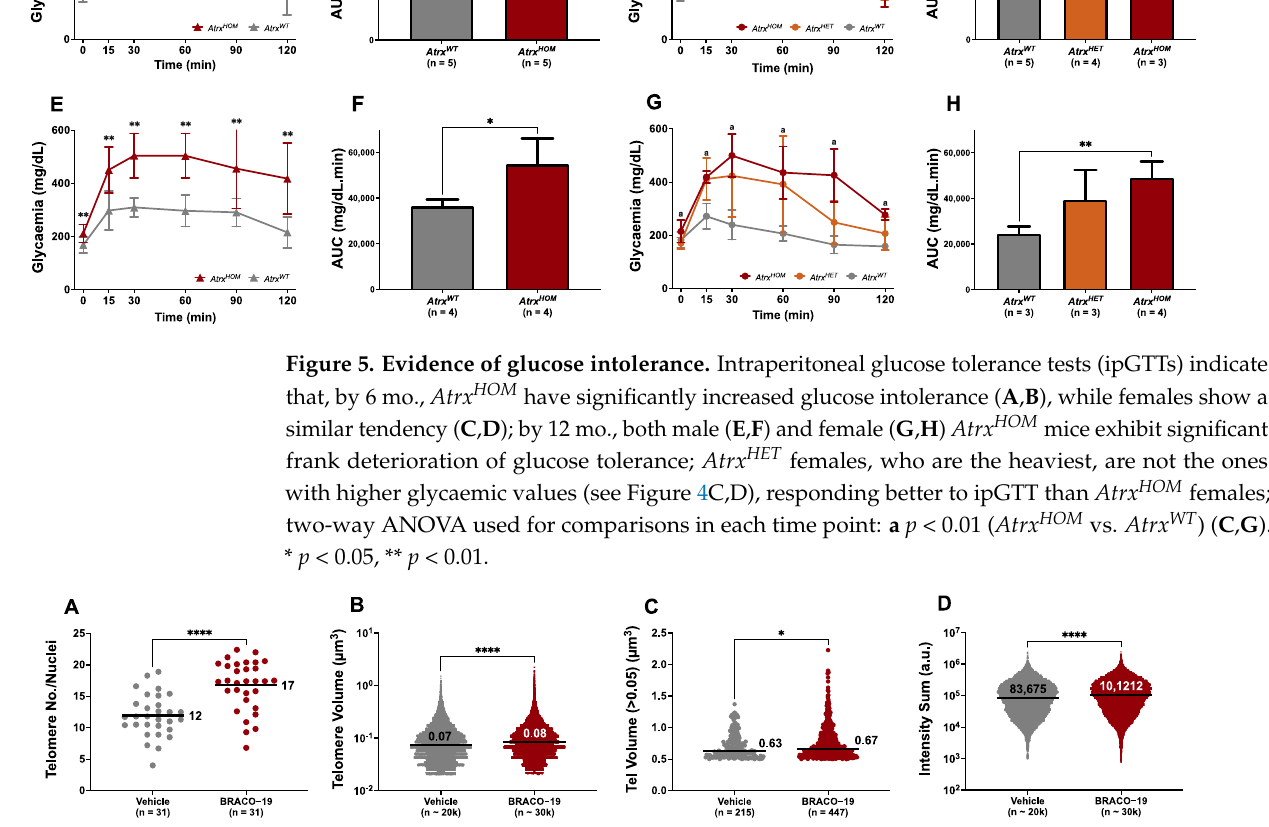
Figure 5. Evidence of glucose intolerance. Intraperitoneal glucose tolerance tests (ipGTTs) indicate that, by 6 mo., Atrx HOM have significantly increased glucose intolerance ( A , B ), while females show a similar tendency ( C , D ); by 12 mo., both male ( E , F ) and female ( G , H ) Atrx HOM mice exhibit significant frank deterioration of glucose tolerance; Atrx HET females, who are the heaviest, are not the ones with higher glycaemic values (see Figure 4C,D), responding better to ipGTT than Atrx HOM females; two- way ANOVA used for comparisons in each time point: a p < 0.01 ( Atrx HOM vs. Atrx WT ) ( C , G ). * p < 0.05, ** p < 0.01.